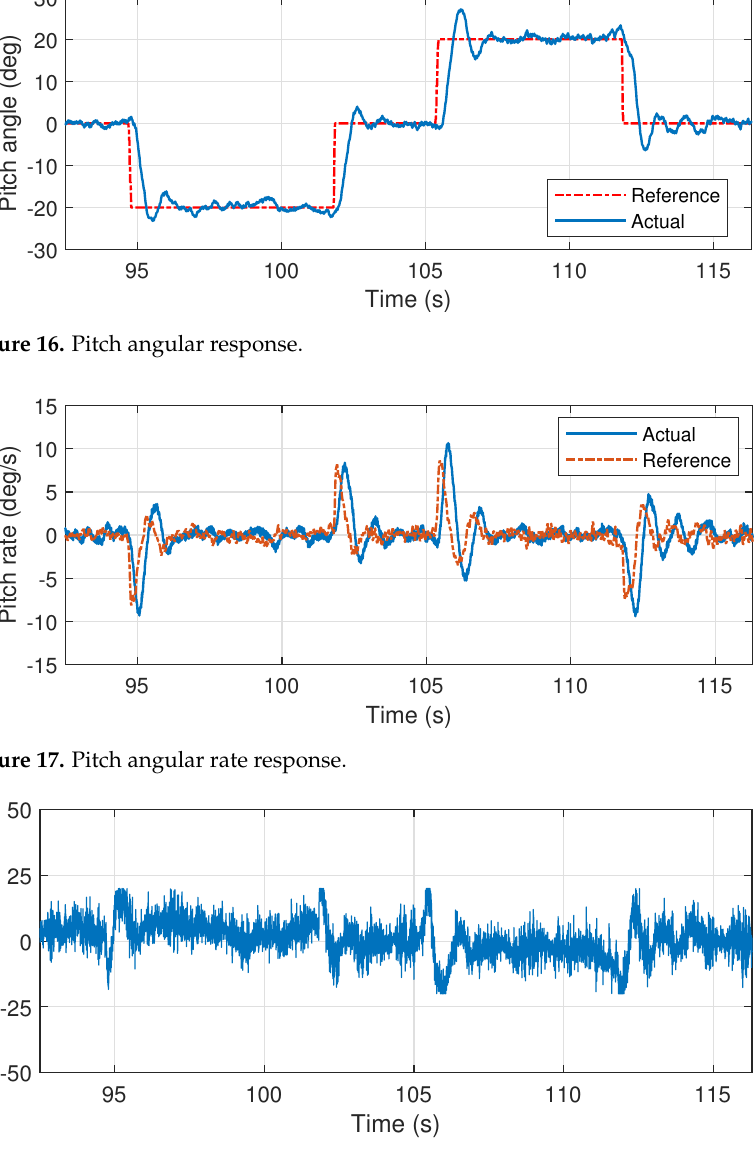
Figure 18. Control signal for pitch axis